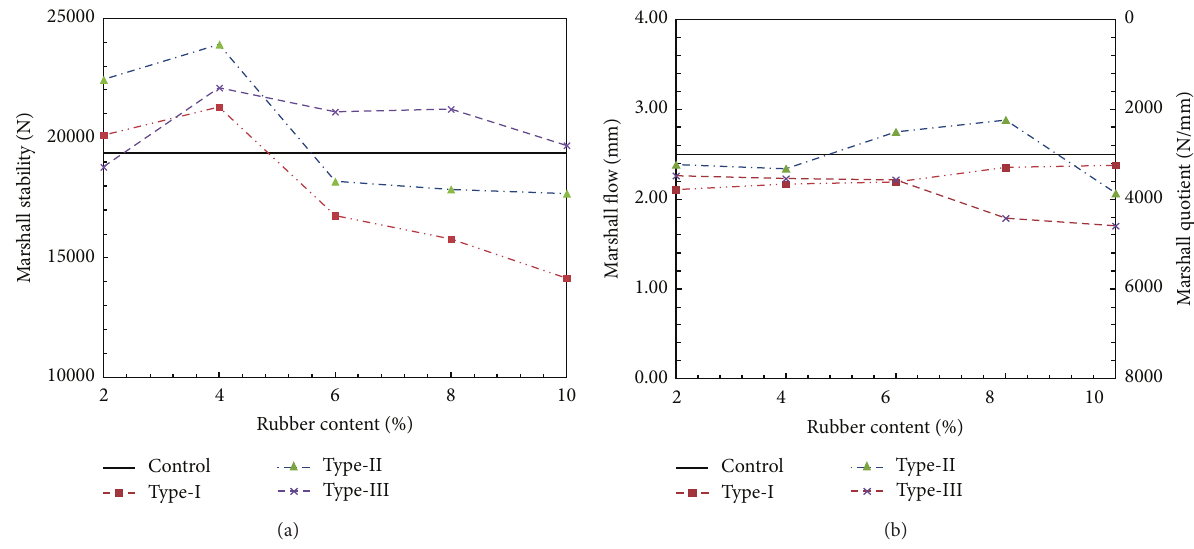
Figure 5: Effect of rubber content on (a) Marshall stability and (b) Marshall flow and